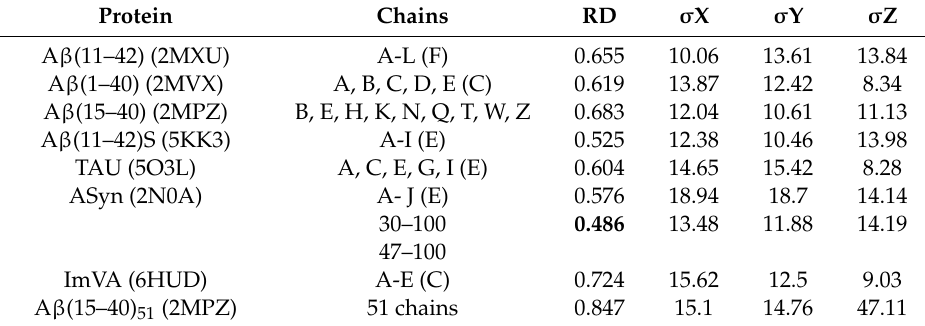
Table 4. RD values for protofibrils. RD value calculated for a 3D Gaussian distribution encapsulating the whole protofibril. The values of the parameters σ X, σ Y, and σ Z are given for expressing the aggregate orientation. Z axis oriented according to the long axis of the fibril. A set of chains included in the protofibrils is given. A central chain that occupies a position in the XY plane is given in parenthesis. Value provided as bold—status consistent with idealized distribution.